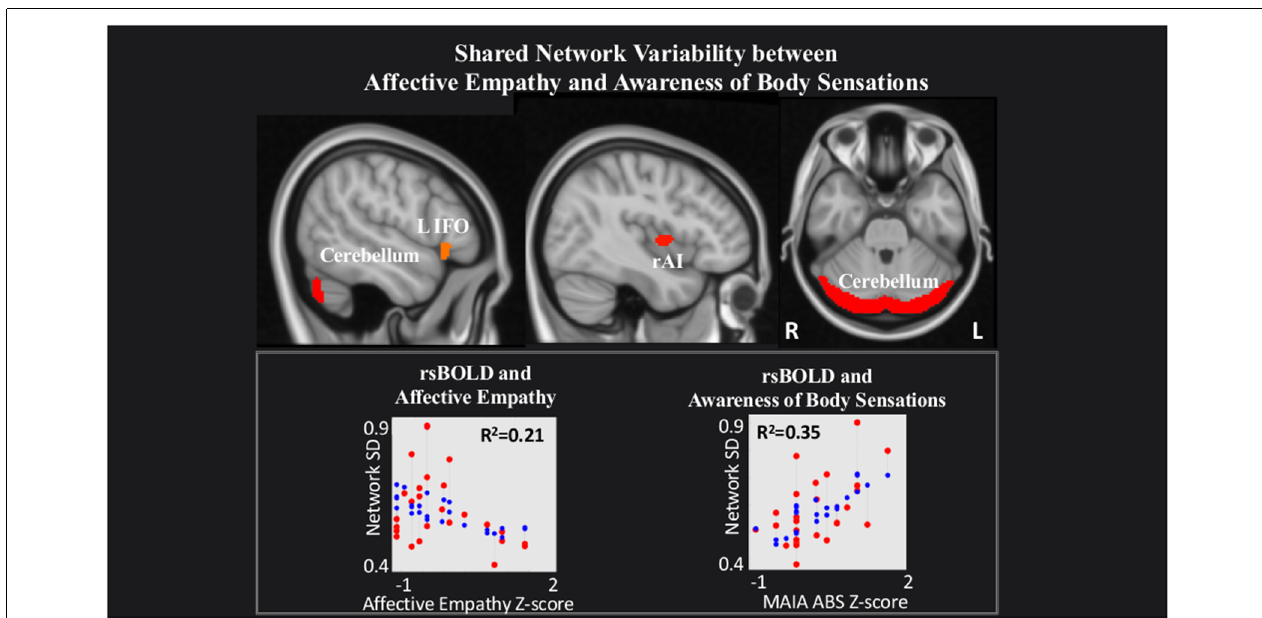
FIGURE 3 | Shared network variability between Affective empathy and MAIA Awareness of Body Sensations. Statistical maps are FDR-corrected within the network at cluster-based p < 0.05, after voxel threshold at p < 0.001, and further corrected for age, gender, and multiple comparisons across components using FDR. Note: the red dots in the graph represent the observed correlation between the standard deviation of the individual network’s BOLD time-series (SD BOLD ) and each subjects’ behavioral measure. The blue dots represent the predicted values of the statistical model. The R 2 value represents the variance explained resulting from the regression between SD BOLD and behavioral variables of interest.